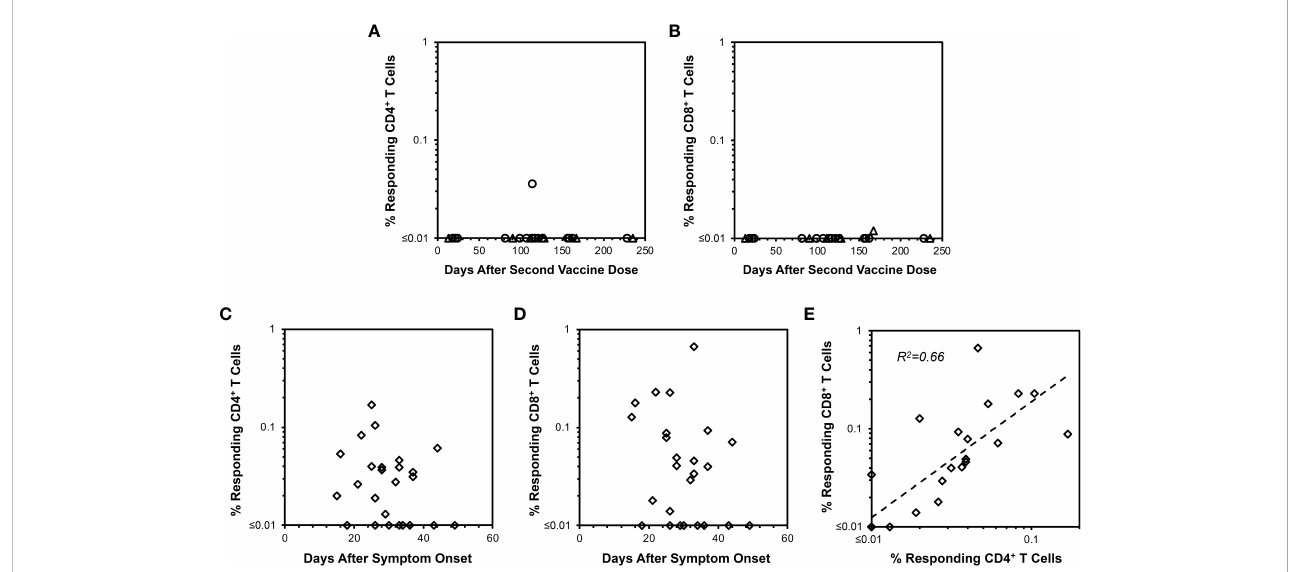
FIGURE 3 CD4+ and CD8+ T cell responses against spike measured by IFN- g intracellular cytokine staining after mRNA SARS-CoV-2 vaccination versus natural infection. Background-subtracted values are plotted for CD4+ and CD8+ T cell spike-speci fi c IFN- g productiondetermined as shown in Figure 2. (A) CD4+ T cell responses are plotted for 22 persons vaccinated with BNT162b2 (18 points from 16 persons, circles) or mRNA-1273 (7 points from 6 persons, triangles). Time points ranged from 13 to 235 days after the second vaccine dose. Only one response was detectable above 0.01% frequency. (B) CD8+ T cell responses measured in parallel are plotted for the same 22 persons in (A) Only one response was detectable above 0.01% frequency. (C) CD4+ T cell responses are plotted for 25 COVID-19-recovered persons ranging from 15 to 49 days after symptom onset. 17/25 (68.0%)